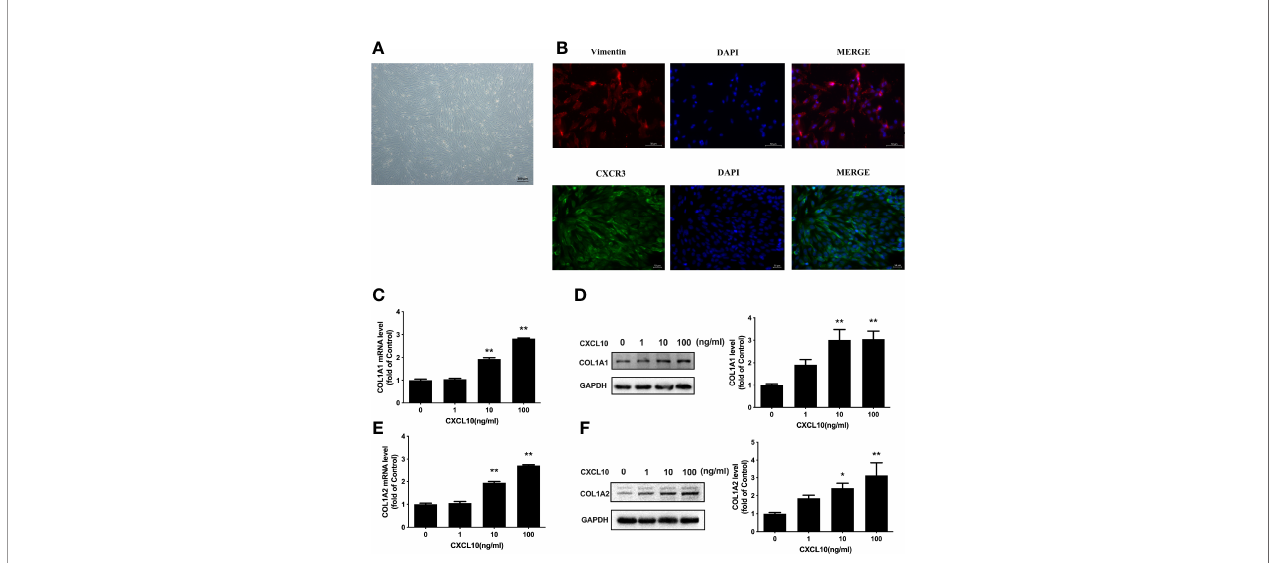
FIGURE 6 | Upregulation of COL1A1 and COL1A2 by CXCL10 in ovarian theca – stroma cells. (A) The morphology of ovarian theca – stroma cells under a microscope. (B) Immuno fl uorescence staining of vimentin (red) and CXCR3 (green) in ovarian theca – stroma cells. (C – F) Ovarian theca – stroma cells were treated with vehicle control (0) and CXCL10 (1, 10, and 100 ng/ml) for 24 h n = 3. (C) COL1A1 mRNA level, (D) COL1A1 protein level, (E) COL1A2 mRNA level, and (F) COL1A2 protein level were measured. * P < 0.05, ** P < 0.01 vs. vehicle control (0).